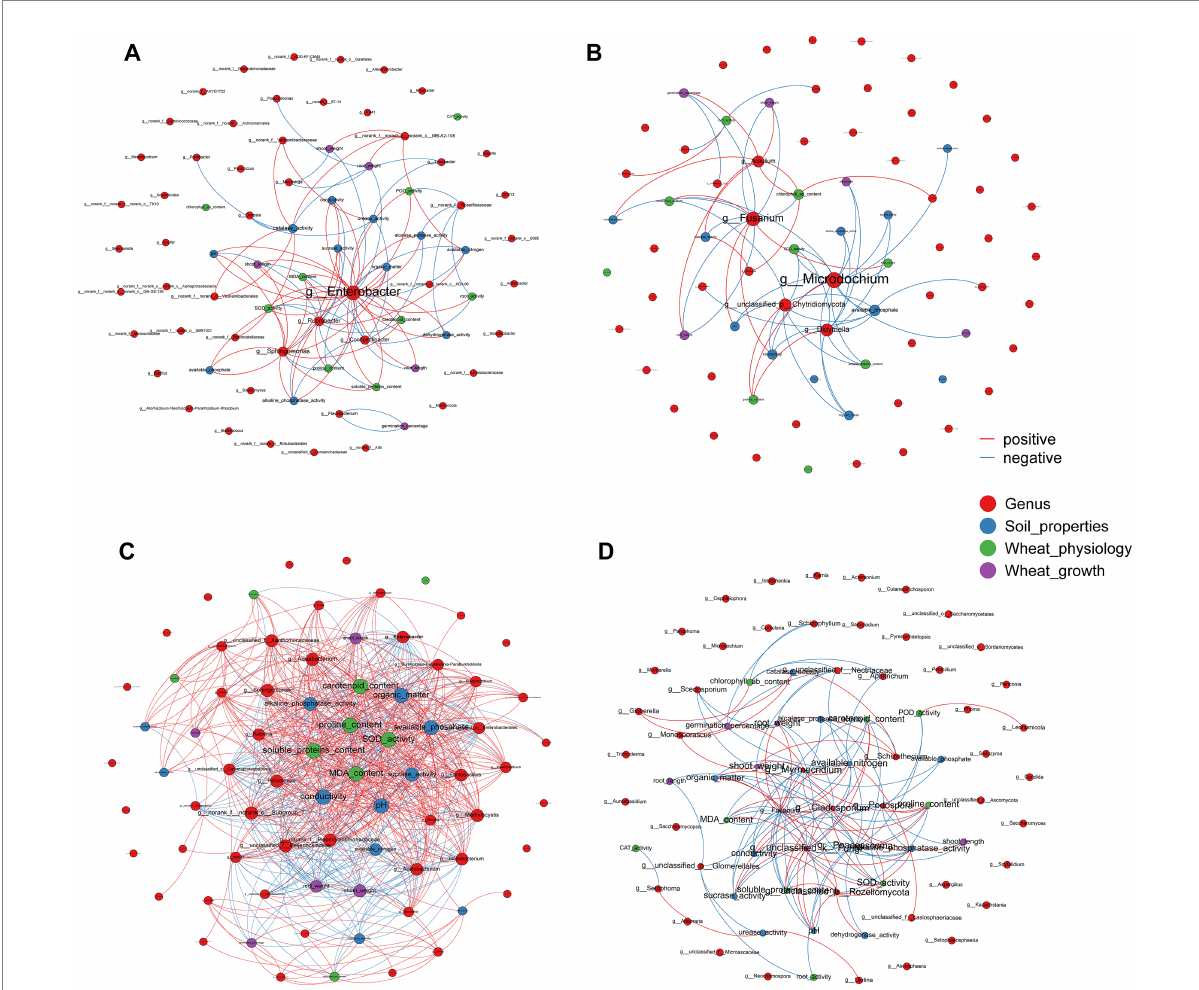
FIGURE 5 Network analysis depicting an interaction pattern among generals of (A) rhizosphere bacterial communities, (B) rhizosphere fungal communities, (C) root endophytic bacterial communities, and (D) root endophytic fungal communities, wheat physiology, soil properties and wheat growth. The size of nodes and labels represent the degree of connection. The red line indicated the positive interaction and blue line indicated negative interaction. The top 50 species with| r | > 0.6 and p < 0.05 were